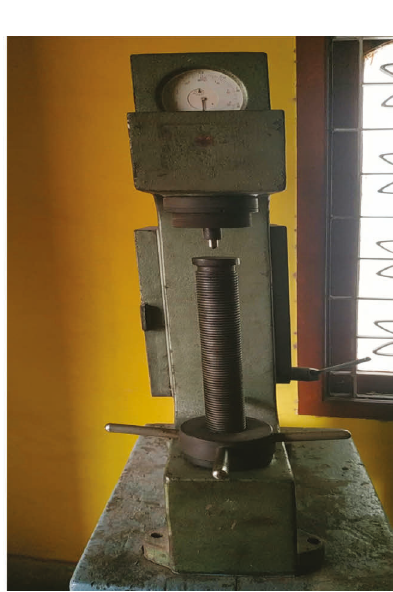
Table 5. The optimal process condition attained S4-T1-R1-P4 for the specified parameter levels, whereas the lowest tensile strength is obtained at the combinational parameters of S1- T2, -R4-P1.